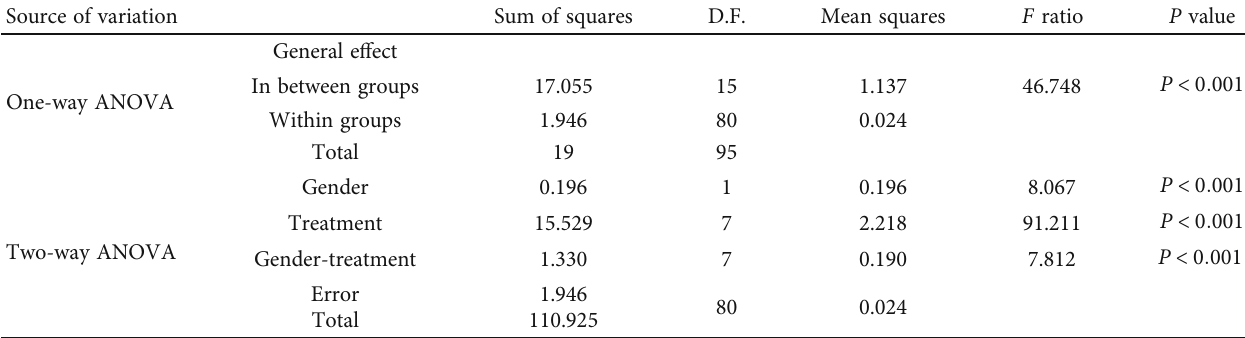
Table 1: E ff ect of gender, group and their interactions on paw circumference in rats (one-way and two-way ANOVA). Source of variation